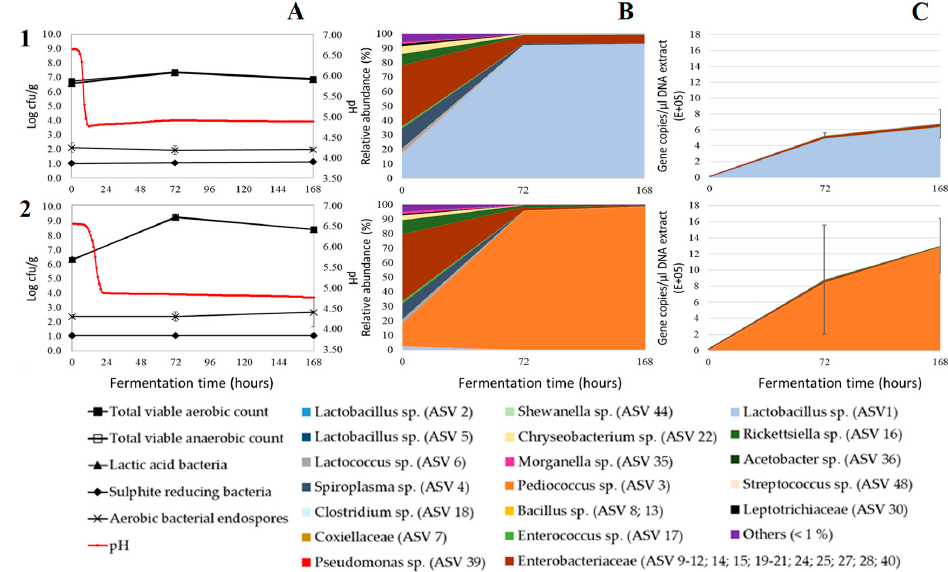
Figure A2. Microbial counts and pH ( A ), relative abundance in the bacterial community ( B ), and estimated absolute abundances (EAA) ( C ) during fermentation of pastes with addition of sodium nitrite and prepared from mealworms of the second production batch, and inoculated with starter Lactobacillus sakei ( 1 ) or Pediococcus acidilactici ( 2 ). The microbial counts and values of relative abundance and EAA are the mean of analyses performed on three replicate samples. Error bars represent the standard deviation. Only amplicon sequence variants (ASVs) represented by an average relative abundance of more than 1% of the sequences in any sample are shown. Other ASVs are grouped together in “others (<1%).